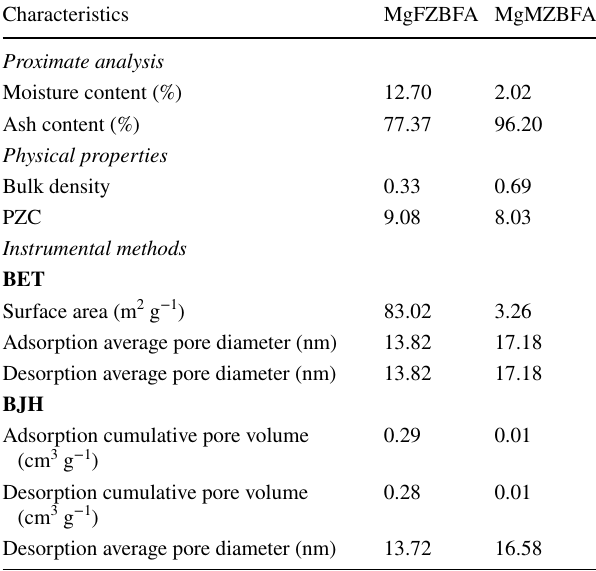
Table 3 Physicochemical properties of MgFZBFA and MgMZBFA